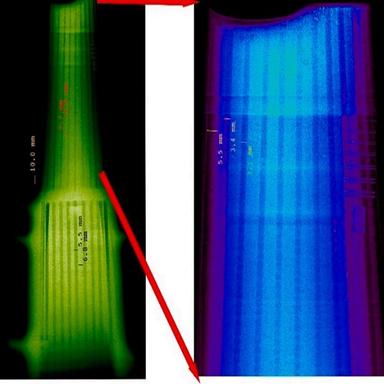
Digital X-ray images of the exposed blade (55,000 h in service).